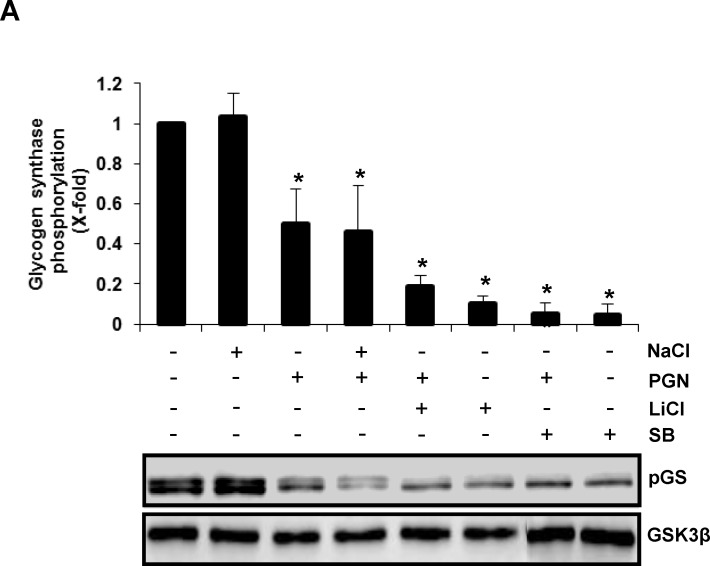
Inhibition of glycogen synthase phosphorylation at Ser641 in BEC treated with PGN, LiCl or SB, and stabilization of β-catenin levels by GSK3α or GSK3β gene silencing.A) BEC were either stimulated with 10 μg/mL of PGN for 30 min, treated with 10 mM NaCl for 60 min, 10 mM LiCl or 10 μM SB and then stimulated with 10 μg/mL of PGN for 30 min. As controls BEC were left untreated (-) or incubated with NaCl, LiCl or SB alone for 60 min. B) BEC were transfected with siRNA targeting GSK3α (siRNA GSK3α), siRNA targeting GSK3β (siRNA GSK3β), control siRNA (siRNA control) or left untransfected (-) for 16 days. After transfection, BEC were incubated for 24 h. Protein extracts were analyzed by western blot and probed with a monoclonal antibody against the phosphorylated form of glycogen synthase (GS Ser641) or the nonphosphorylated form of β-catenin. To verify that equal amount of protein was loaded in each lane, blots were stripped and reprobed with antibodies that recognize the nonphosphorylated forms of GSK3β (A) or β-actin (B). Blots are representative of three independent experiments. Graphs indicate the band intensity obtained by densitometric analysis. Results are expressed as the mean ± S.E.M. (n = 3). *p<0.05, compared with the untreated (A) or untransfected (B) control.